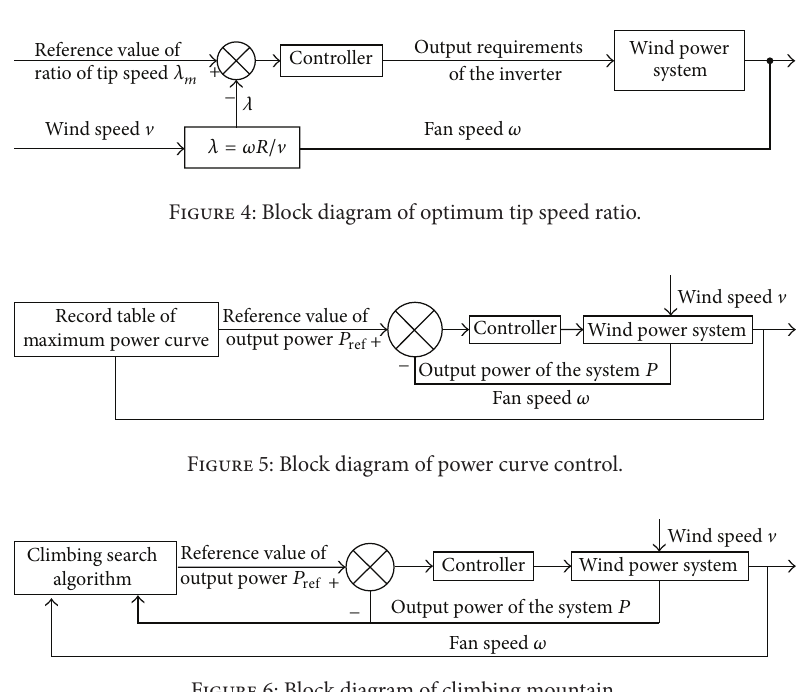
Figure 6: Block diagram of climbing mountain.